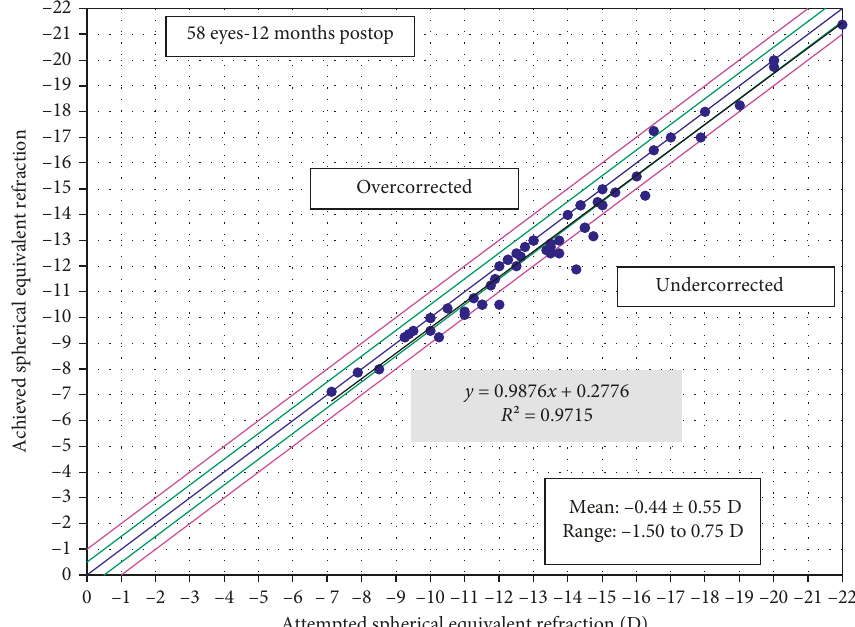
Figure 4: Attempted versus achieved spherical equivalent of manifest refraction.